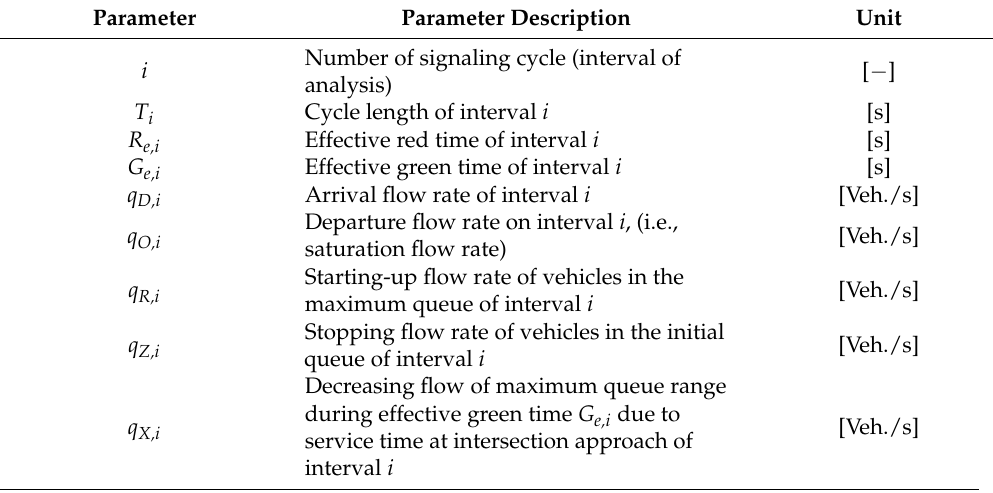
Figure 4. Diagram of the process of the volatility of the back-of-queue size in time and the formation of the maximum back-of-queue size in a given signaling cycle i . Table 2. The summary of the characteristics of the examined intersections and the collected